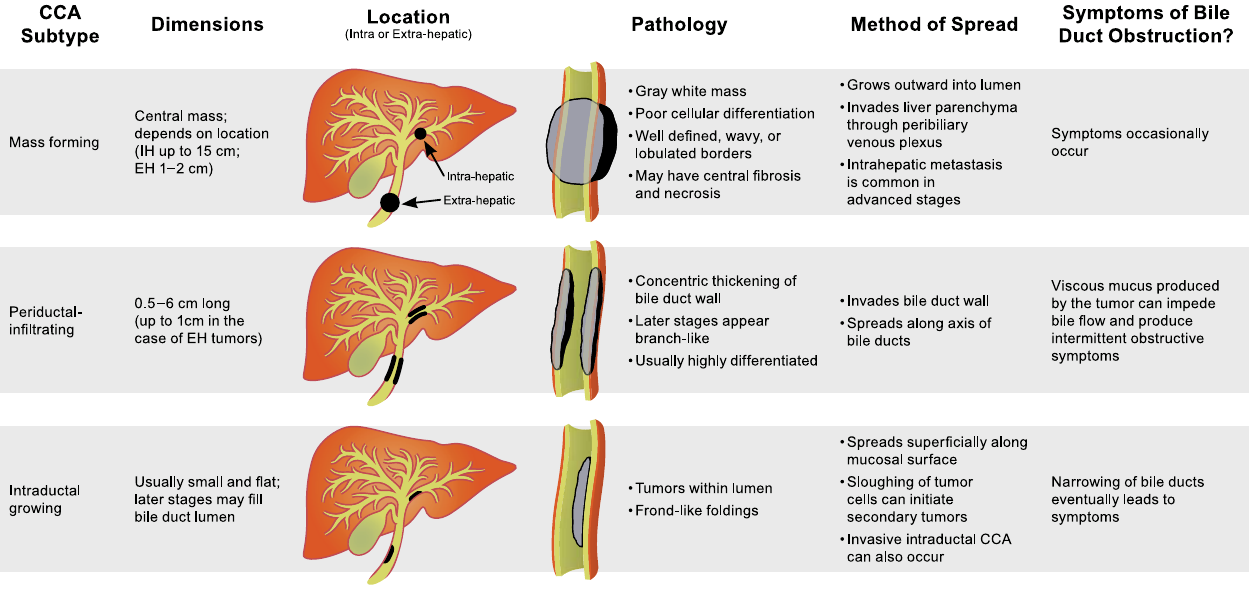
Figure 4. Characteristics of CCA Morphologically this cancer falls into three subtypes: mass forming, periductal infi ltrating, and intraductal. This classifi cation is independent of the location of the affected bile duct, which may be intrahepatic (within the liver) or extrahepatic (outside the liver, excluding the gallbladder). The line between these subtypes tends to blur as the malignancy matures. Tumour dimensions, mode of spreading, and clinical manifestations are noted. Adapted from [36,37] by Giovanni